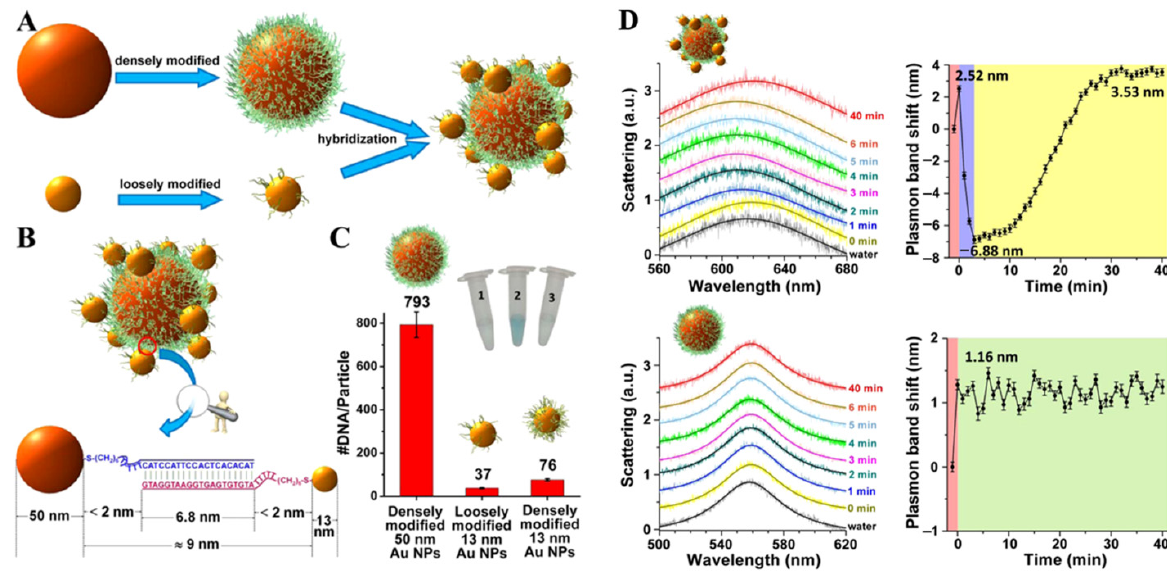
Figure 5. ( A ) Synthetic scheme for the preparation of Au nanohalo through the self-assembly of Au NPs of different diameters modified with complementary oligonucleotides. ( B ) Schematic demonstration of the distance between L- and S-Au NPs, which is determined by the rationally designed length of oligonucleotides. ( C ) Number of oligonucleotides per particle of different kinds of L- and S-Au NPs. Inset shows the colored product that is catalyzed by L- and S-Au NPs that loaded different amounts of oligonucleotides. ( D ) LSPR spectra and the corresponding band peak shifts of one Au nanohalo (up) and one L-NPs (down) during the catalytic reaction under the same experimental condition. Reprinted with permission from [48]. Copyright 2015 American Chemical Society.